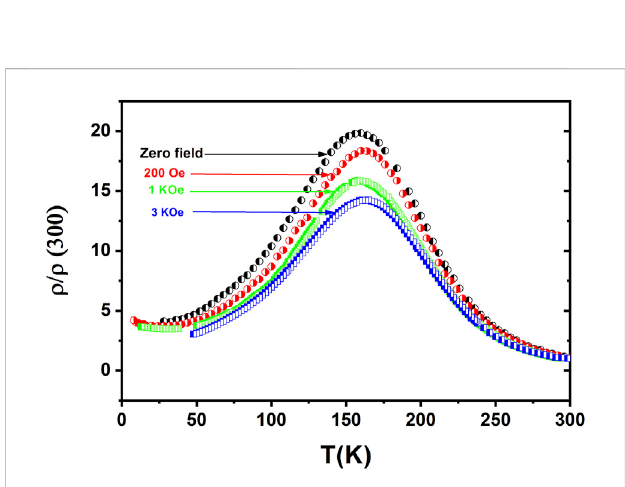
FIGURE 10 Temperature-dependent resistivity curves under different magnitudes of the magnetic fi eld of La 0.8 Ca 0.2 MnO 3 for x =